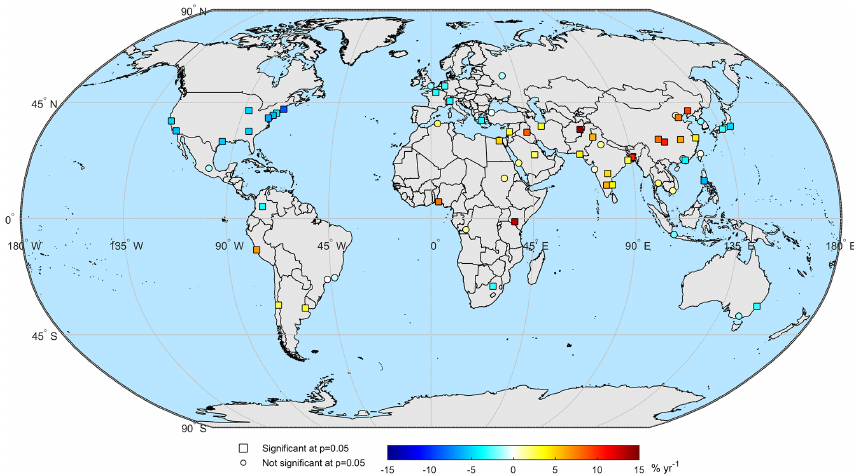
Figure 3. Global map of relative 2002–2012 tropospheric NO 2 trends over all studied urban agglomerations. The relative trends in units of yr − 1 are given with respect to the long-term average concentration computed over the entire time series at each grid cell individually. The names of all the studied urban agglomerations as well as the exact absolute and relative trend values for each site can be found in Table .